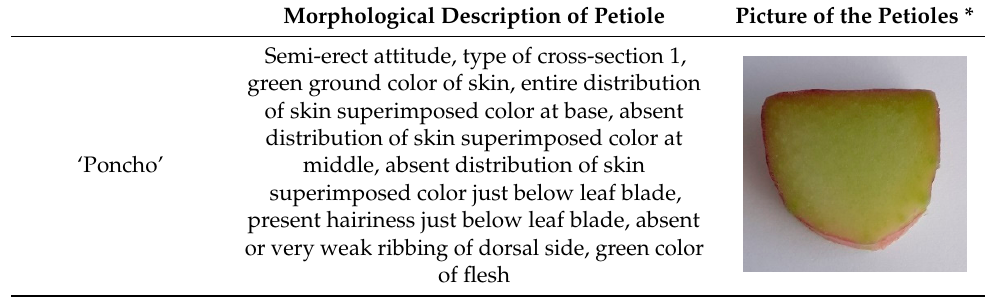
ribbing of dorsal side, green color of